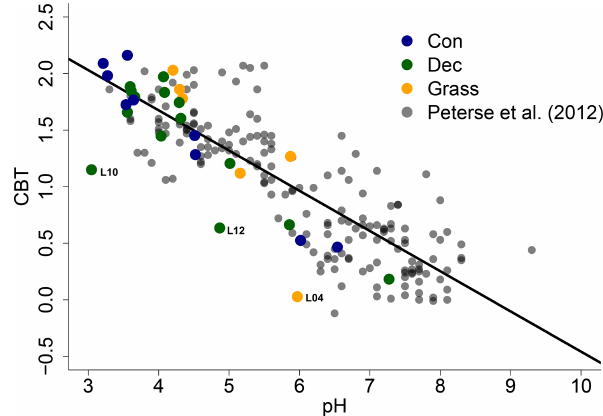
Figure 4. CBT-to-pH relationship in our dataset in compari- son to the global calibration dataset from Peterse et al. (2012) (CBT =− 0 . 36 × pH + 3 . 1, r 2 = 0 . 7, p value < 0.0001, n = 176, black line). Abbreviations: con: coniferous forest sites ( n = 9); dec: deciduous forest sites ( n = 14); grass: grassland sites ( n = 6).